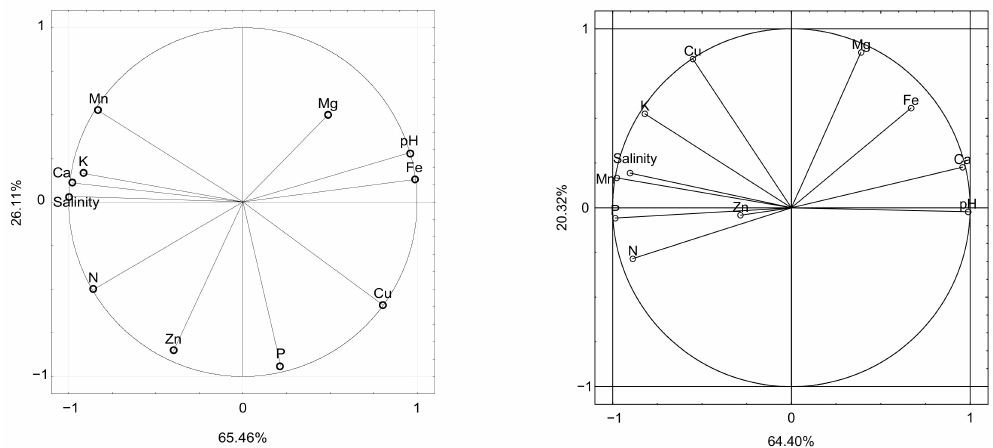
Figure 1. The principle component analysis (PCA) for acidifying substances and minerals in tested soils.